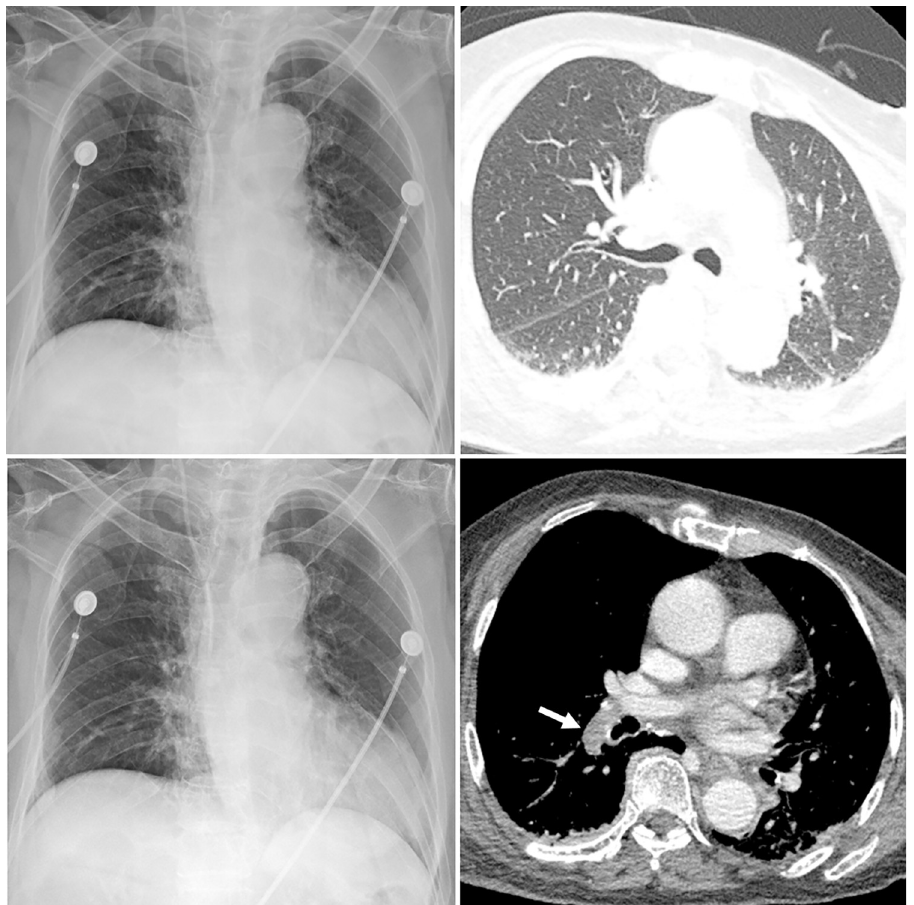
Fig 3. Representative case without COVID-19 pneumonia. A CXR ( A ) and corresponding chest CT ( B ) of a patient with fever and dyspnea but negative RT-PCR result for COVID-19 show no pulmonary abnormality suggestive of pneumonia. The CAD system did not detect any abnormalities in the CXR and the probability score was 13% ( C ). In the reader-alone interpretation, four thoracic radiologists and four non-radiologist physicians misclassified the CXR as having findings of pneumonia. In the CAD-assisted interpretation, only one thoracic radiologist and two non- radiologist physicians made false-positive classification of the CXR. Mediastinal window CT image ( D ) show pulmonary embolism in the right descending pulmonary artery (arrow), presumed cause of patients’ symptom.